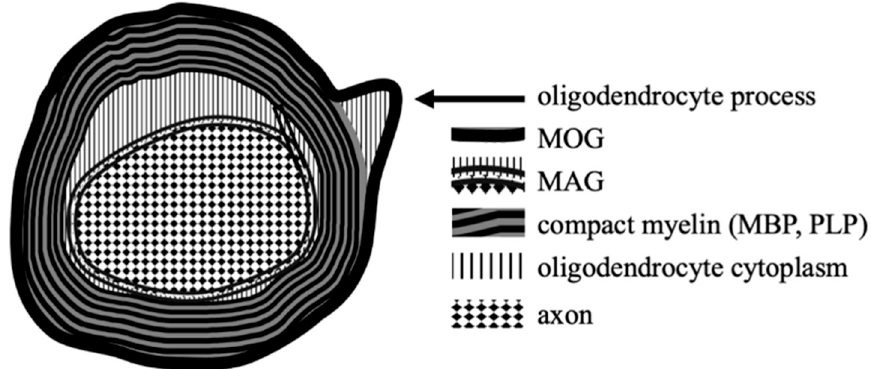
Figure 1. The locations of MOG and other myelin proteins on oligodendrocytes within CNS.